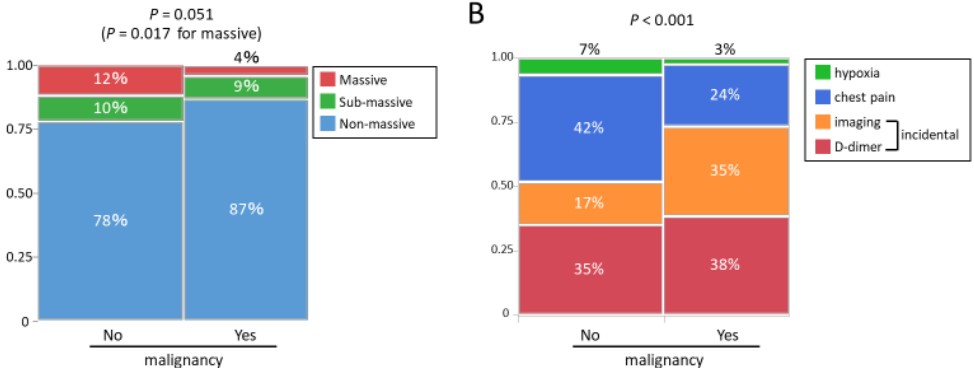
Figure 2. ( A ) The severity of PE and ( B ) the primary trigger leading to the diagnosis of PE: ( A ) The malignancy group showed a significantly smaller proportion of massive PE. ( B ) In the no ‐ malig ‐